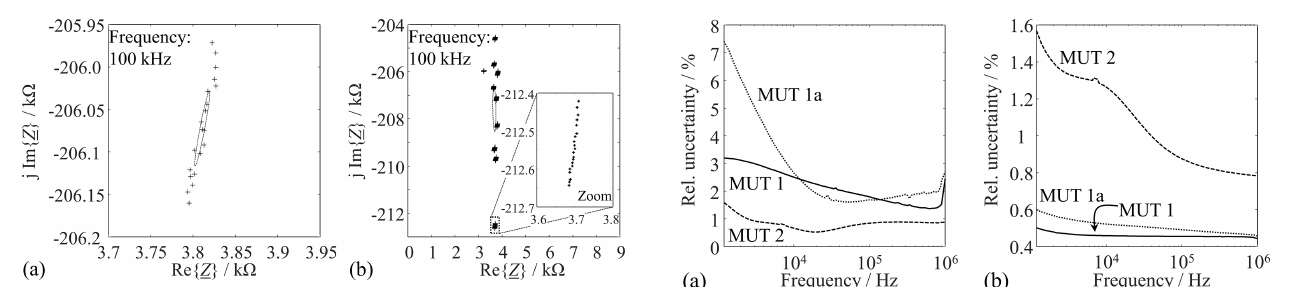
Figure 7. Relative uncertainties plotted over the frequency for (a) the measured resistance and (b) the measured reactance with various